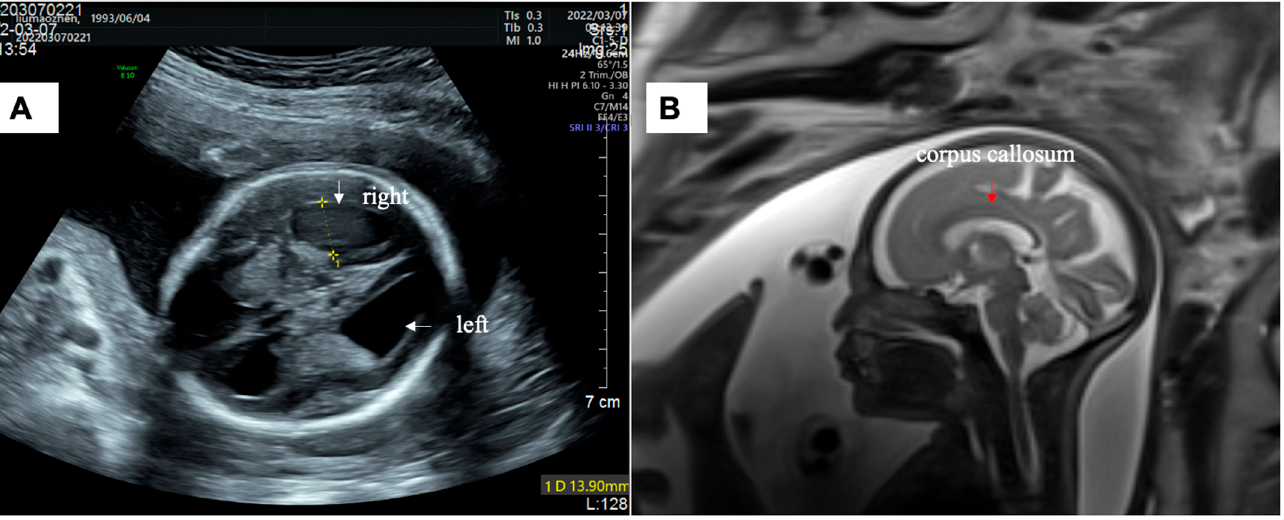
Figure 2. ( A ) Sonographic images of Fetus 2 showing lateral ventriculomegaly (left: 15 mm; right: 14 mm) at the 23-week scan. ( B ) Brain MRI images showing an intact corpus callosum.